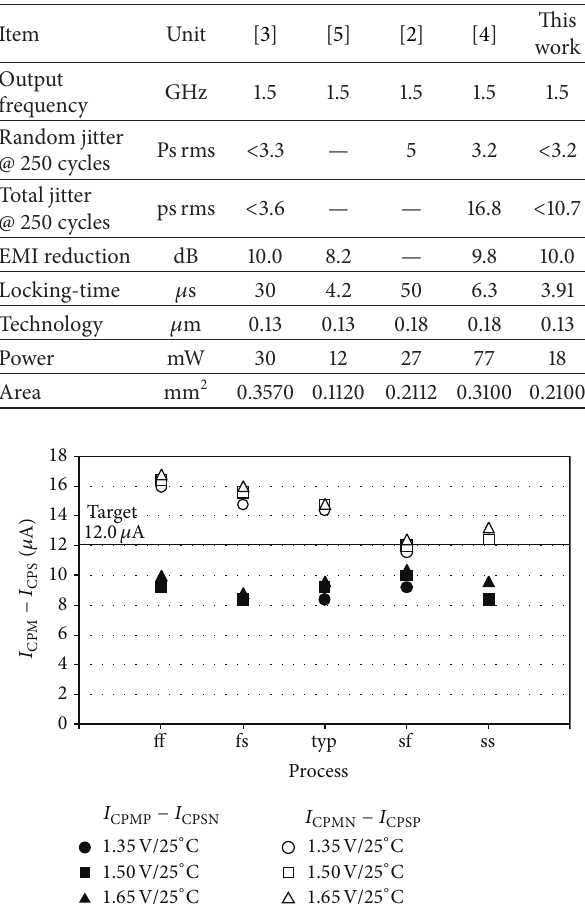
Table 1: Comparison table.